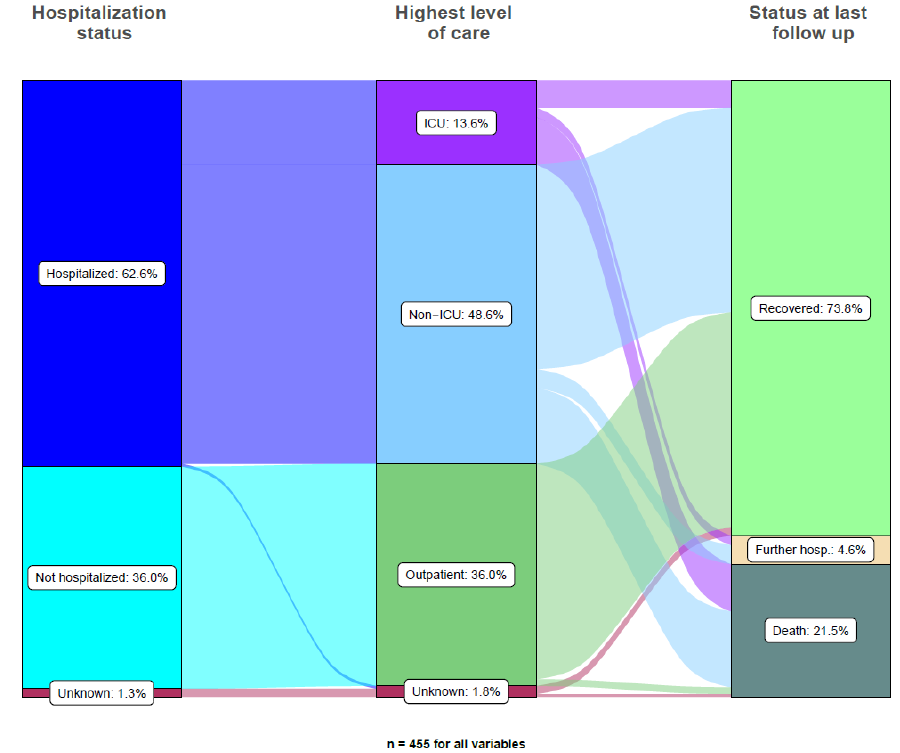
Figure 1. Alluvial plot of hospitalization and clinical courses for all 455 cancer patients.